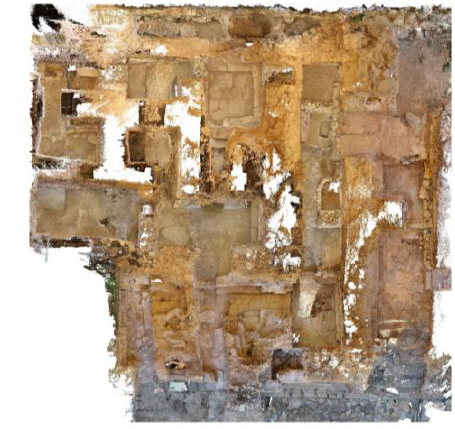
Figure 5. Canon point cloud (Metashape): top view Both point clouds were finally georeferenced to the laser scanner point cloud. The referencing was done on Metashape, assigning to 10 points of each dense cloud the coordinates of their counterparts, extrapolated (using Cyclone) from the laser scanner point cloud.